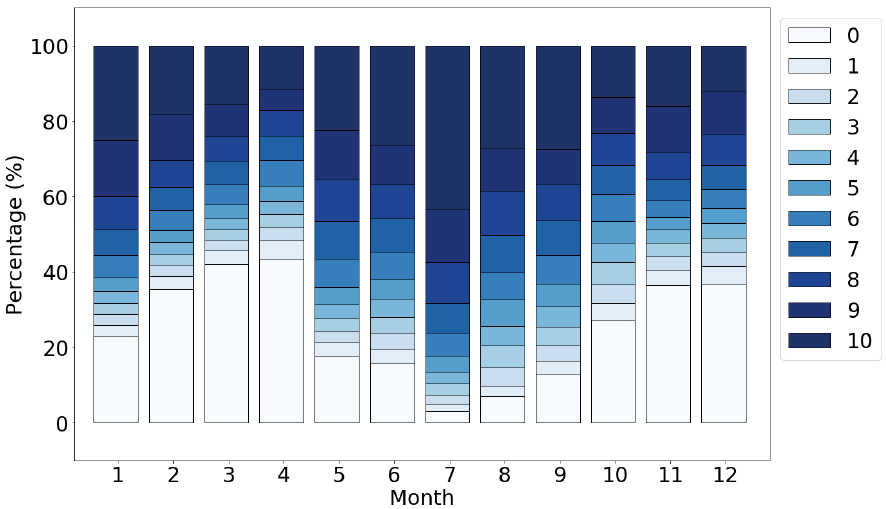
Figure A2. Monthly distributions of cloud cover in our experimental dataset (January 2017–December 2020). Cloud cover had imbalance distributions within each month. Moreover, the distributions were different for each